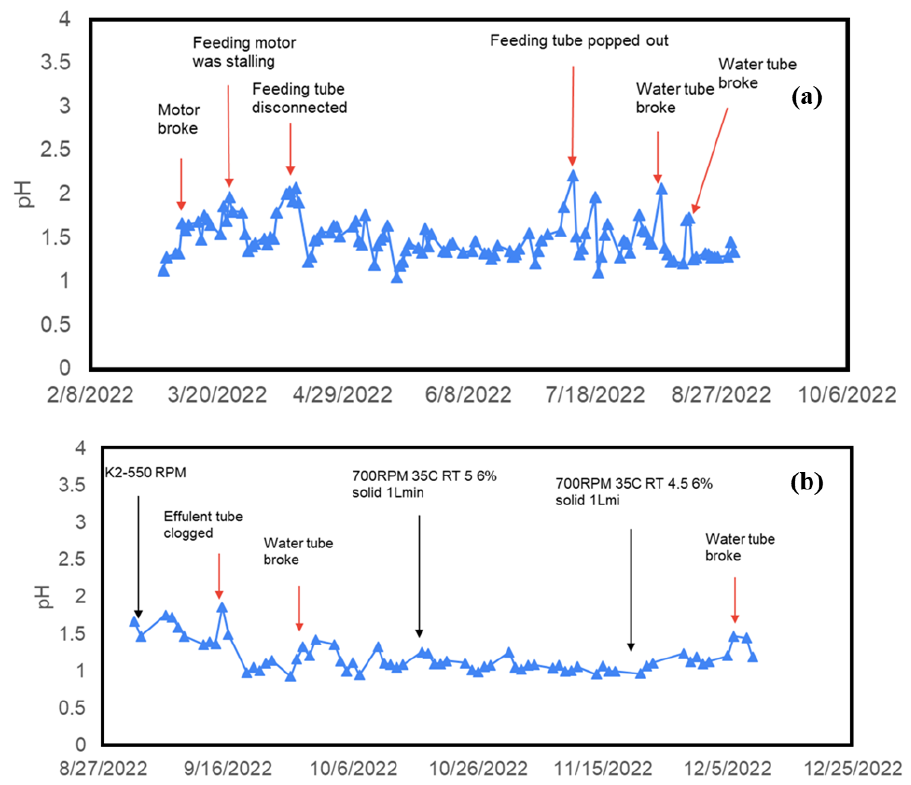
Figure 4. ( a ) Comparison of pH data in the WBB 419 bioreactor from 3 March 2022 to 31 August 2022. ( b ) Comparison of pH data in the WBB 419 bioreactor from 9 January 2022 to 12 September 2022.